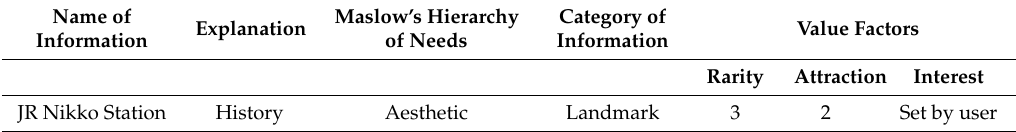
Table 5. Details of sightseeing